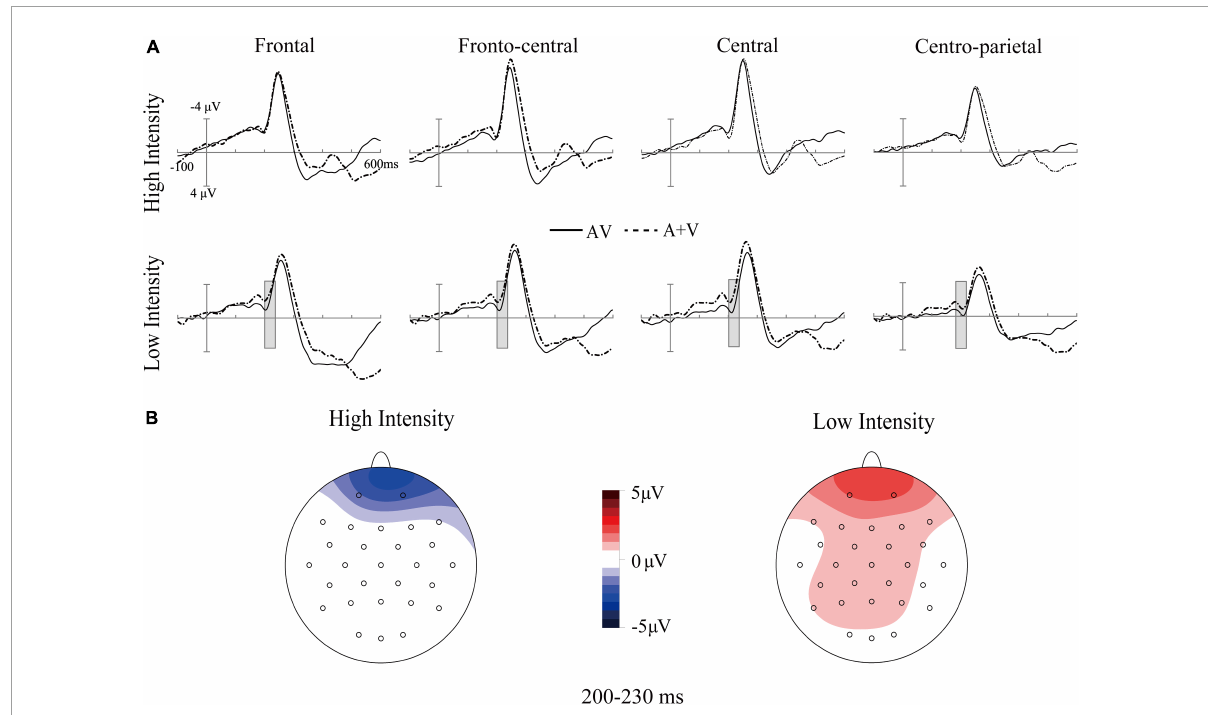
FIGURE3 Grand-average event-related potentials of audiovisual stimuli (AV) and the sum of visual and auditory stimuli (A + V) from 100 ms before the stimuli to 600 ms after stimulus onset (A) , as well as the topographic map of audiovisual integration [AV–(A + V)] (B) in older adults under high- and low-intensity conditions. The gray cubes represent the integration time window at 200–230 ms relative to auditory onset, mainly illustrating inverse effectiveness in older